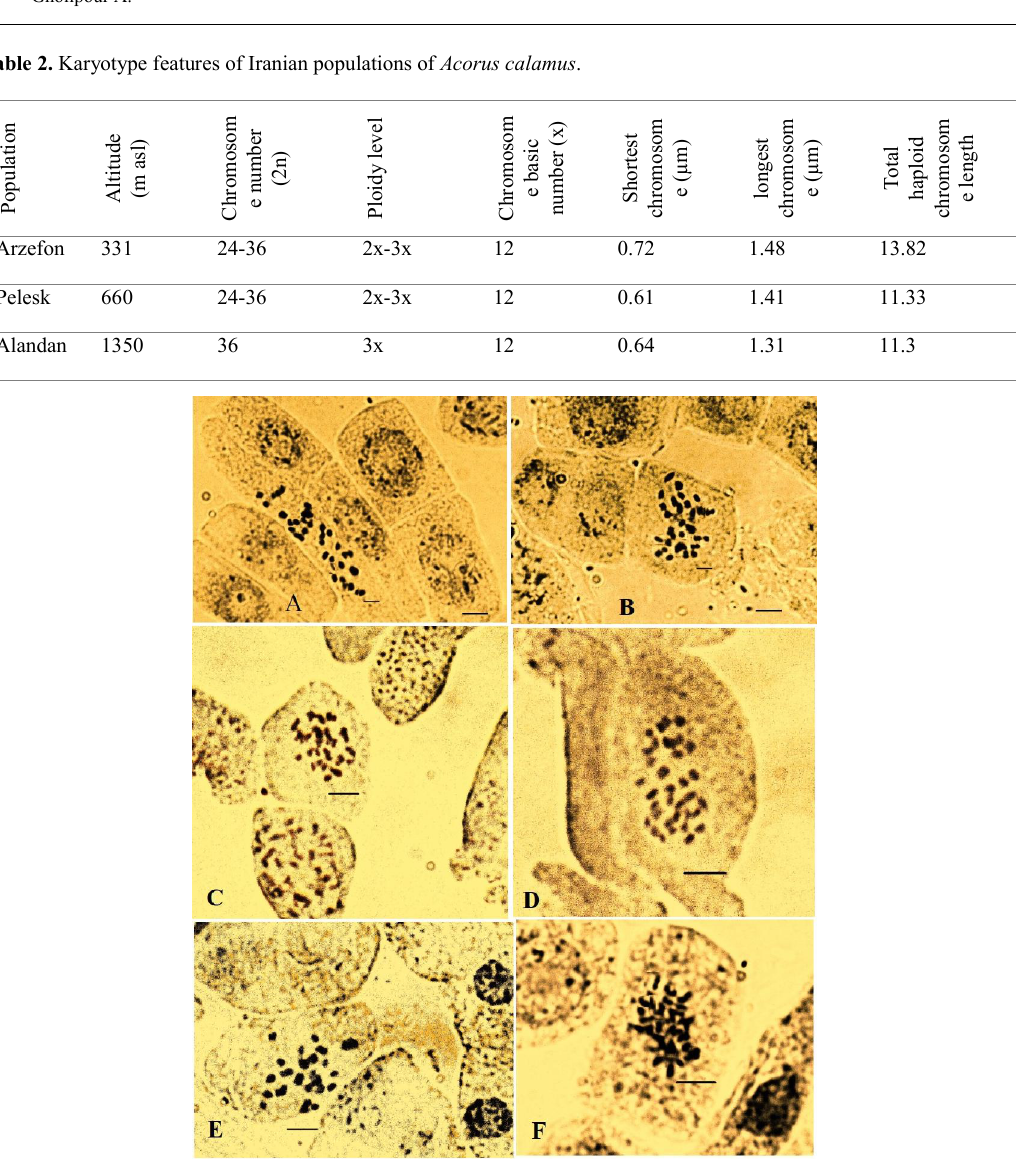
Fig.1. Karyotype of Iranian populations of A. calamus: A-B. Triploid cytotype (2n=3x=36) of Alandan population, C. diploid cytotype (2n=2x=24) of Pelesk population, D. triploid cytotype (2n=3x=36) of Pelesk population, E. diploid cytotype (2n=2x=24) of Arzefon population, F. Triploid cytotype (2n=3x=36) of Arzefon population (Scale bar = 5